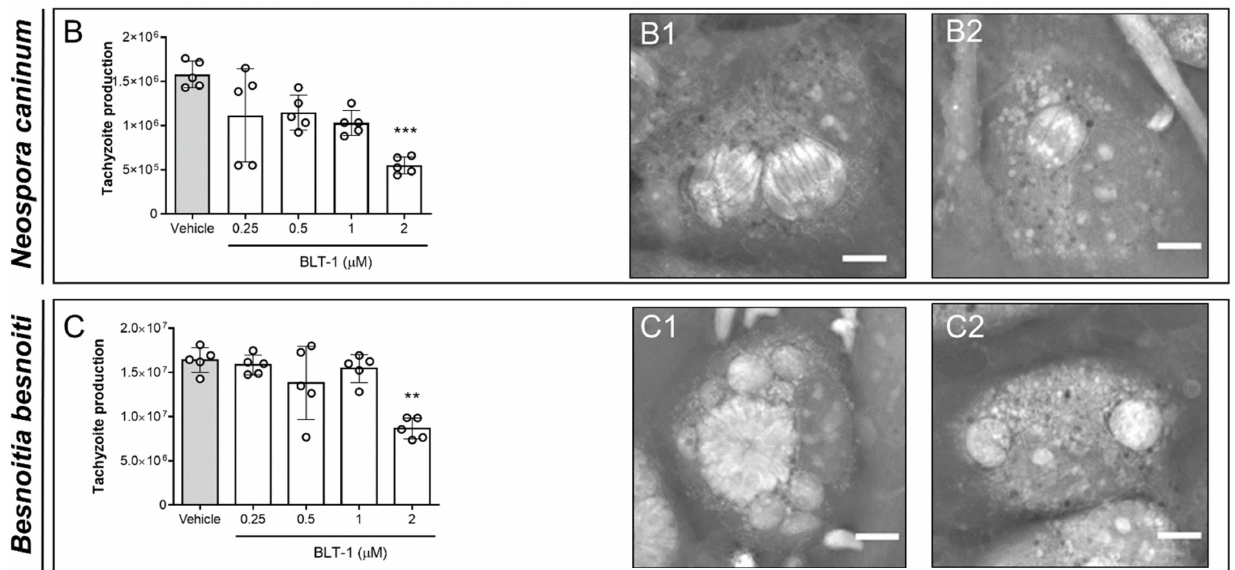
Figure 1. BLT-1 treatments inhibit T. gondii , N. caninum and B. besnoiti intracellular tachyzoite proliferation in primary bovine umbilical vein endothelial cells (BUVEC). BUVEC were treated with BLT-1 (0.25, 0.5, 1 and 2 µ M) 48 h before ( A ) T. gondii , ( B ) N. caninum or ( C ) B. besnoiti infection. The number of tachyzoites present in cell culture supernatants were counted 48 h after infection ( A – C ). Exemplary live cell 3D holotomographic illustration of BLT-1-treated and non-treated T. gondii- ( A1 , A2 ), N. caninum- ( B1 , B2 ) or B. besnoiti -infected ( C1 , C2 ) BUVEC at 24 h p.i. Scale bar: 5 µ m. Bars represent the means of five biological replicates ± standard deviation; ** p ≤ 0.01; *** p ≤